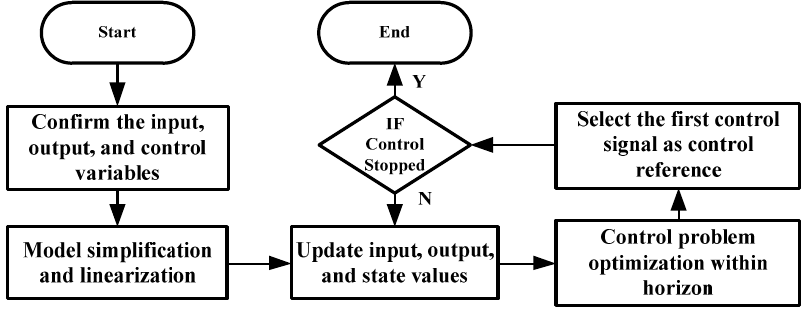
Figure 7. Flow chart of MPC implementation procedure.